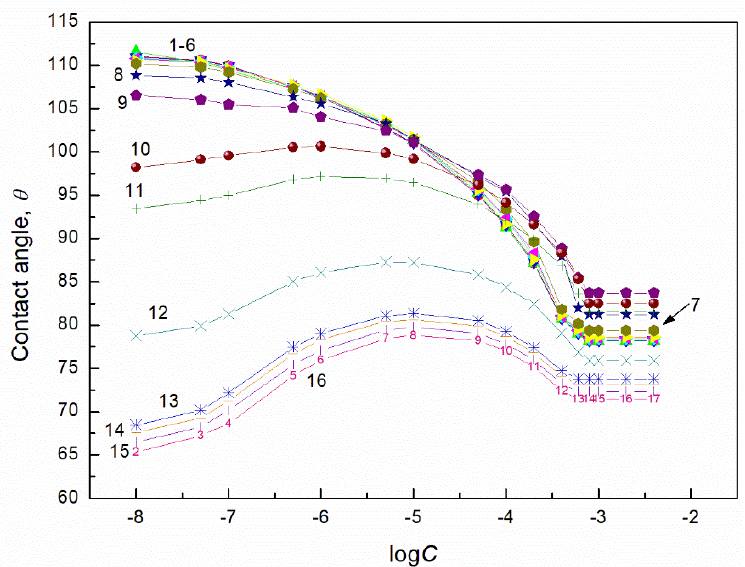
Figure 3. A plot of the contact angle ( θ ) of aqueous solution of TX165 + SF mixtures on the PTFE surface vs. the logarithm of the TX165 concentration ( C ). Curves 1–16 correspond to the constant SF concentration equal to 0.0002, 0.0005, 0.00125, 0.003, 0.00625, 0.01, 0.02, 0.05, 0.1, 0.5, 1, 5, 10, 20, 30 and 40 mg/dm 3 , respectively.